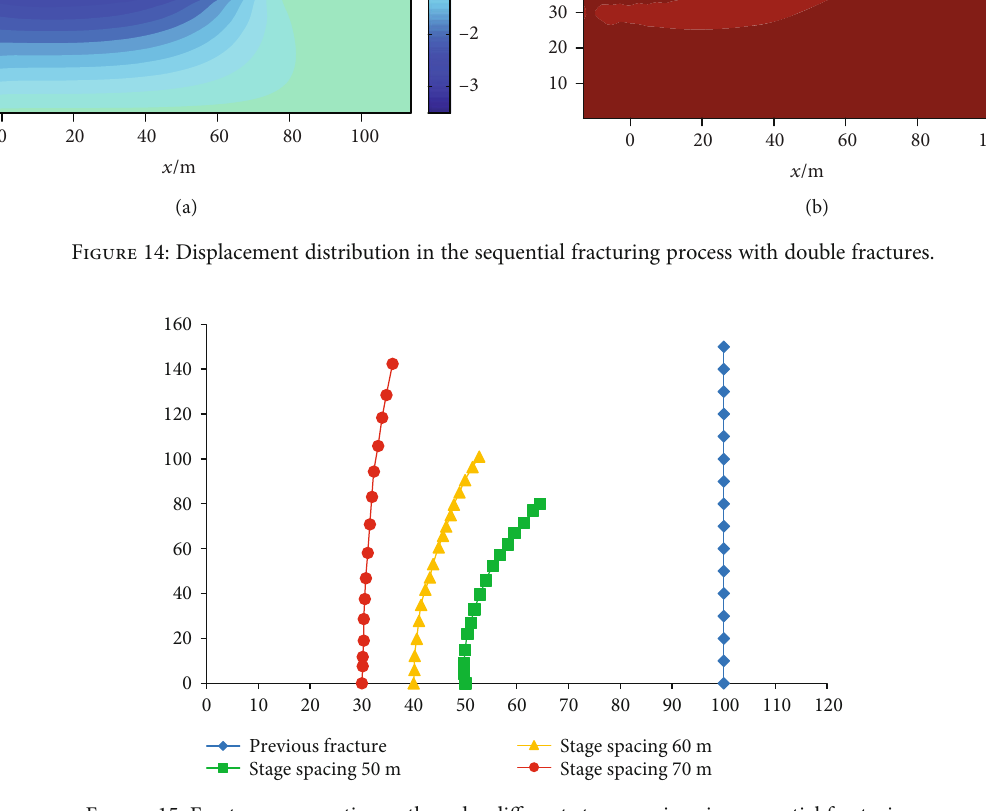
Figure 15: Fracture propagation path under di ff erent stage spacings in sequential